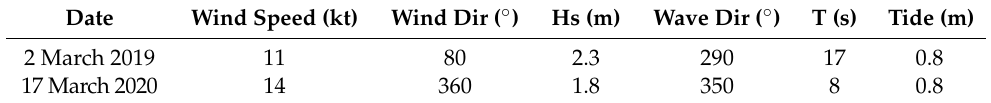
Table 2. Waves and wind parameters during the Pleiades acquisitions.